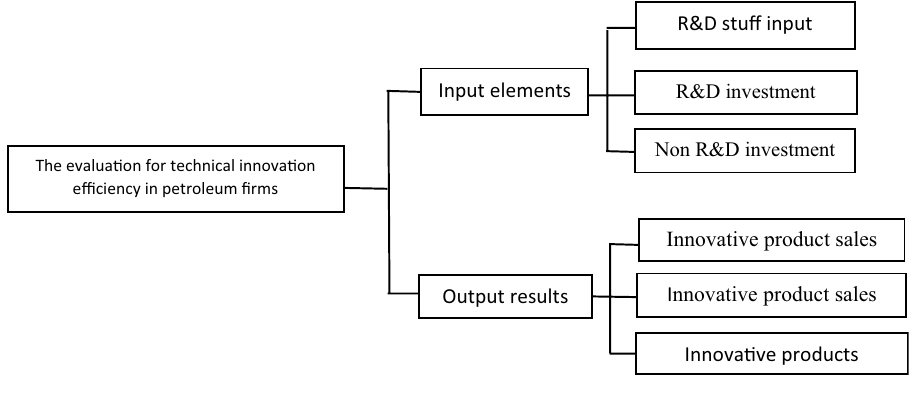
Fig. 1 Evaluation index